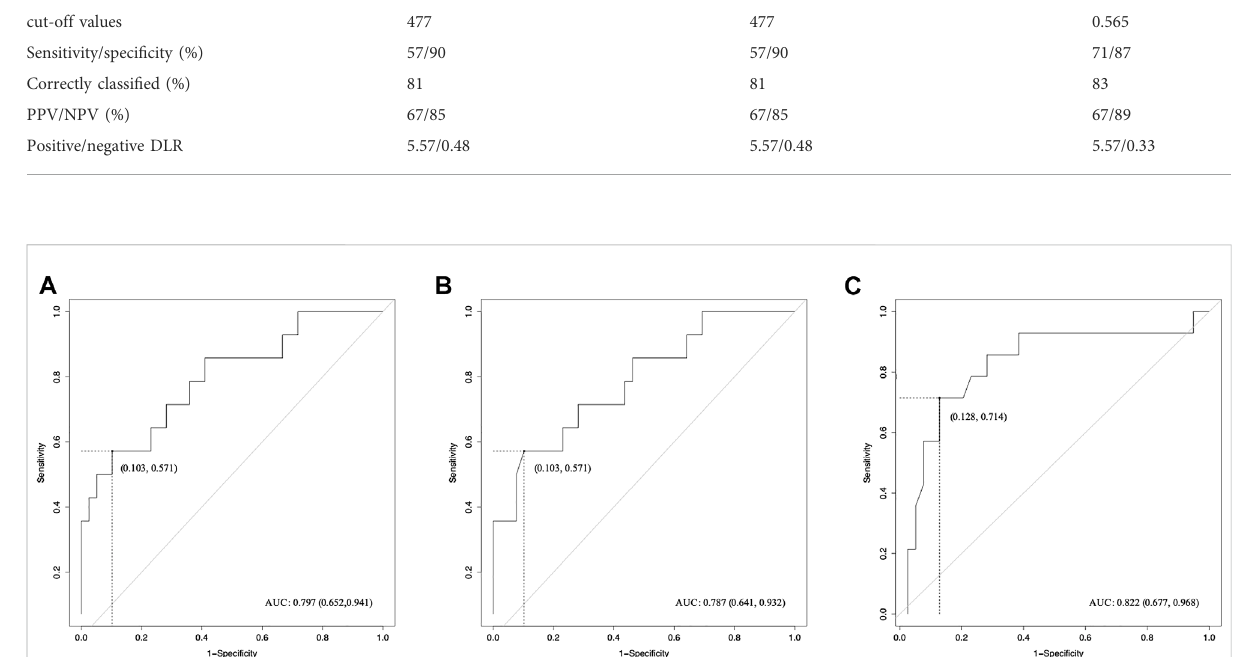
FIGURE 5 ROC curves of radiomics features for the prediction of sonication dose. (A) BX of tROI, (B) BX of nfROI and (C) Circ of nfROI predicting sonication dose. The cut-off values were estimated according to themaximum of theYouden index. tROI,region of interest oftumor; nfROI, region of interest of near fi eld; ROC, receiver operator characteristic, AUC, the area under the ROC